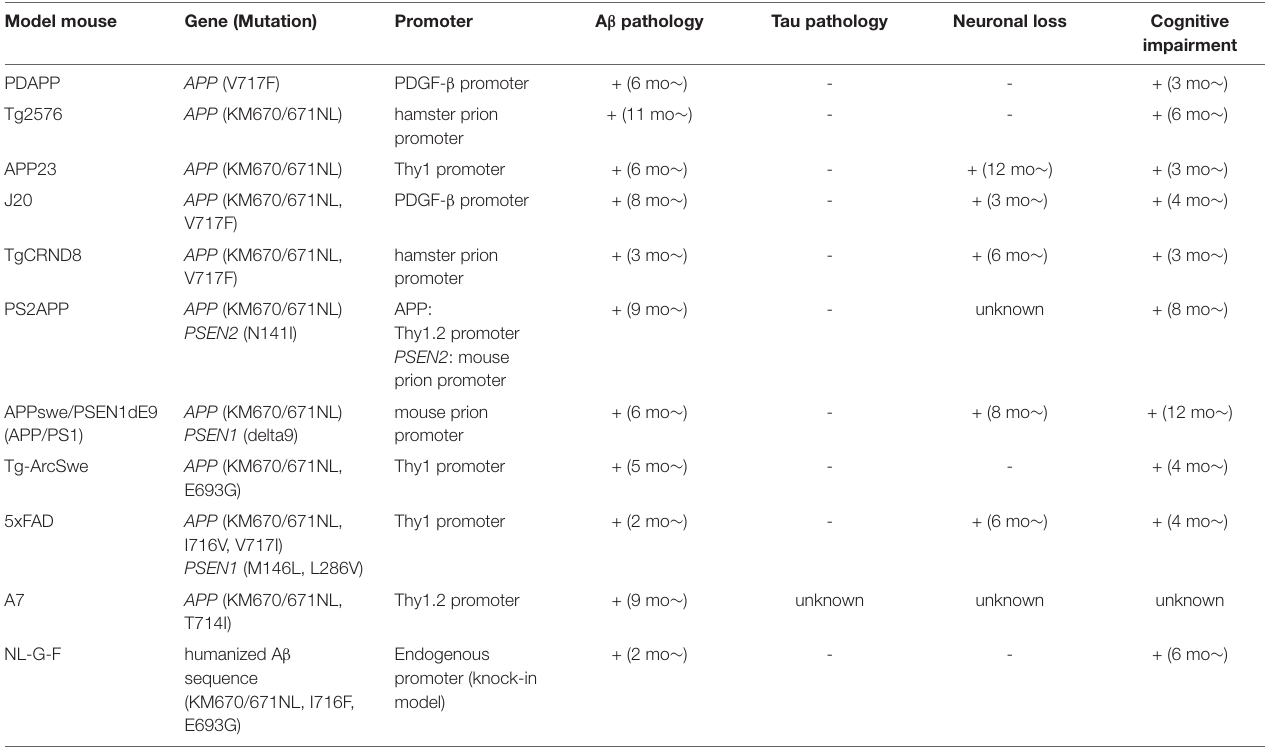
TABLE 3 | Representative APP model